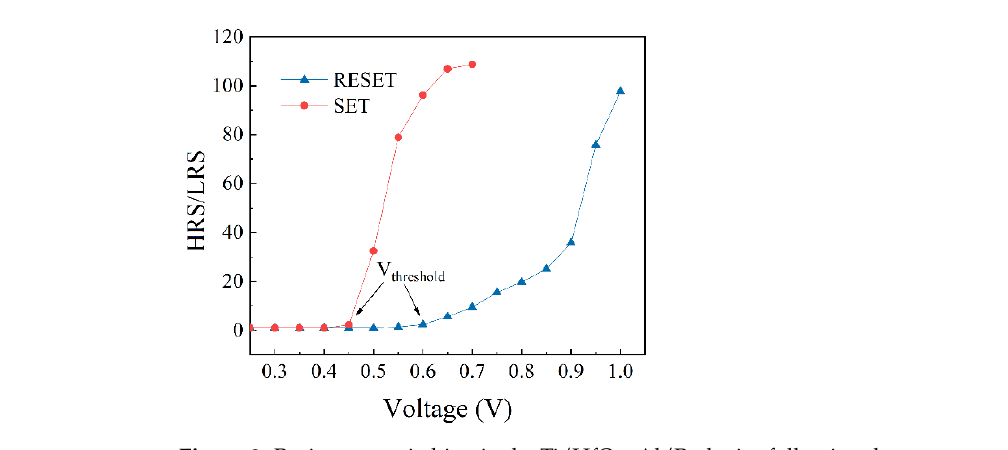
Figure 3. Resistance switching in the Ti/HfO 2 : Al/Pt device following the sequence of voltage pulses with varying amplitudes. The current range was set to 10 mA. (V read = 0.1 V). The typical dynamic current responses of the voltage pulse are shown in Figure 4.